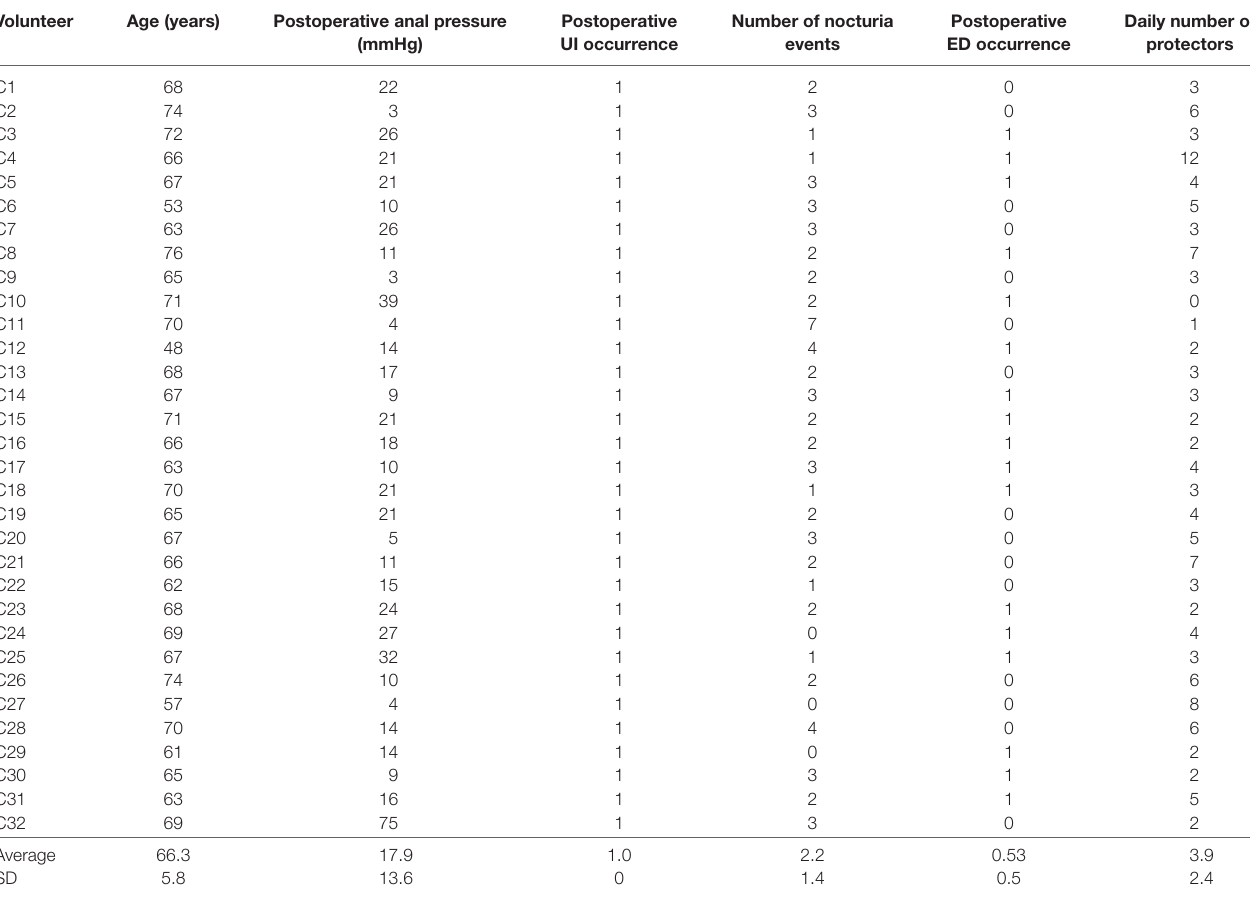
tABLe 1 | Control group’s measured data regarding age, postoperative anal pressure, urinary incontinence occurrence, number of nocturia events, erectile dysfunction occurrence, and daily number of protectors (disposable underwear for male urinary incontinence) used after prostatectomy.